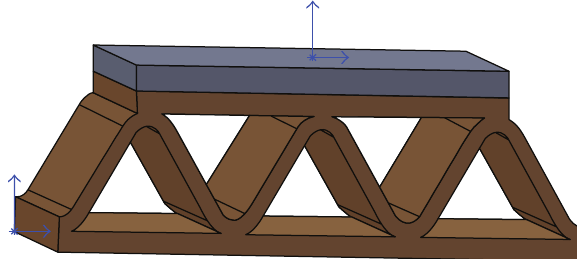
Figure 4: Model of corrugated board with two